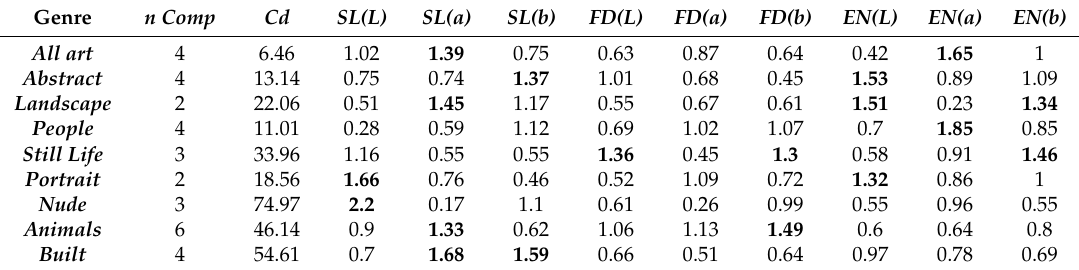
Table 2. Summary of best-fitting PLSR models applied to paintings in di ff erent genres